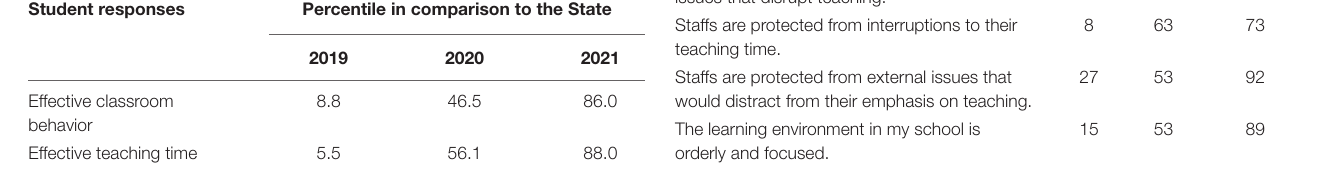
TABLE 3 | Attitudes to school survey – effective teaching practices for learning. Student responses